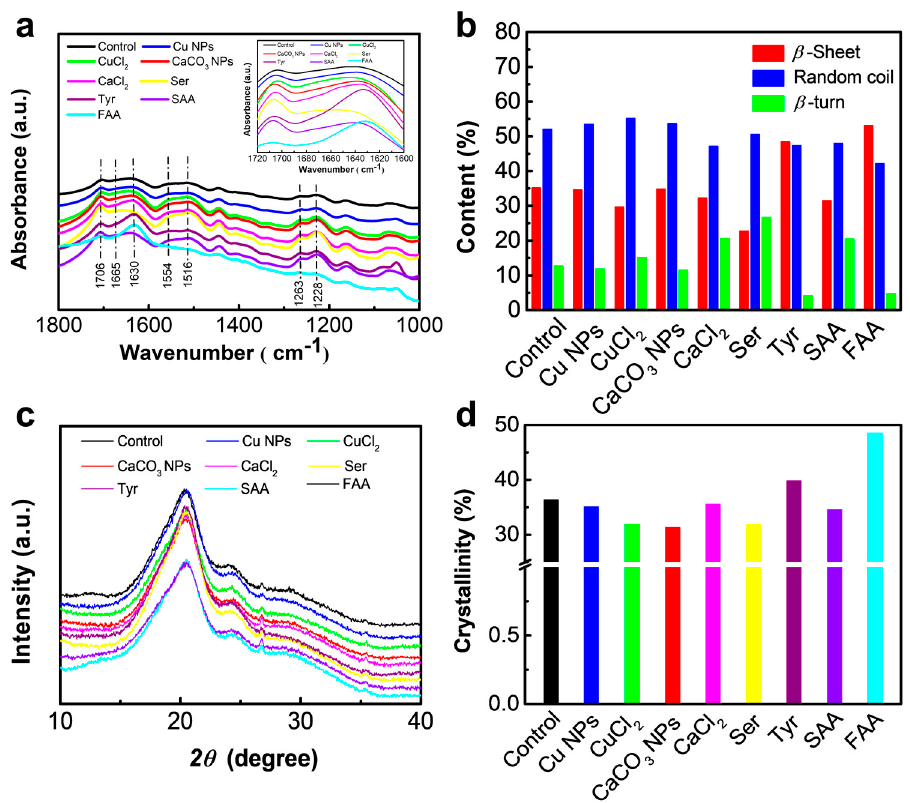
Figure 2. Secondary structure of silk fibers. ( a ) Fourier-transform infrared (FTIR) spectra of silk fibers obtained from normal and modified diets and the small image is the FTIR spectra in amide I band; ( b ) content of β -sheet, β -turn and random coil after deconvolution of FTIR spectra in amide I band. ( c ) X-ray diffraction (XRD) spectra of silk fibers; ( d ) Crystallinity percentage of silk fibers. The X axis for ( b , d ) is silk fiber samples obtained from different diet additives and the control is the normal silk obtained from traditional diet without any additives. (Ser = serine, Tyr = tyrosine, SAA = sericin amino acid, FAA = fibroin amino acid).